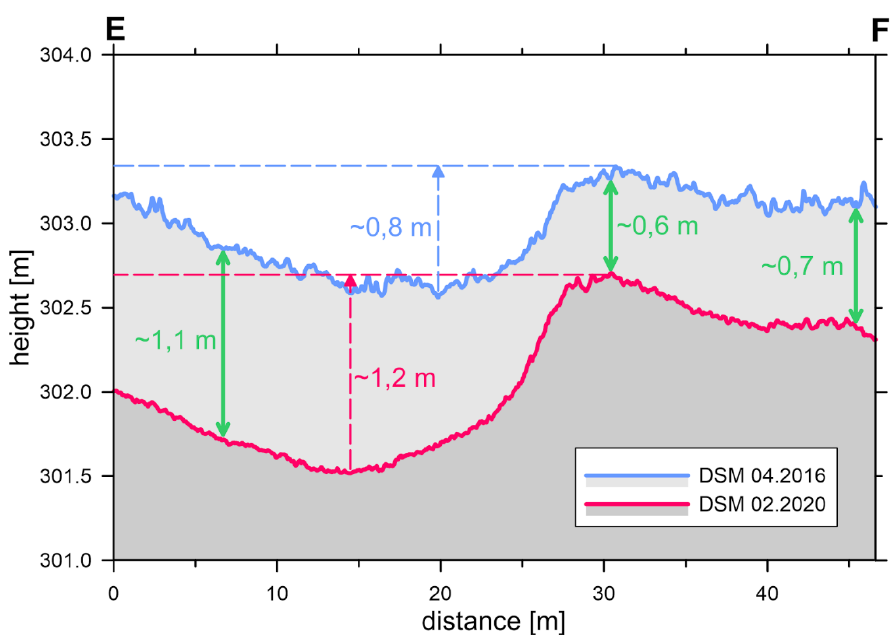
Figure 12. Morphology of the discontinuous deformation and its cross-sectional change (E–F profiles) between 04.2016 and 02.2020 (Jaworzno site).